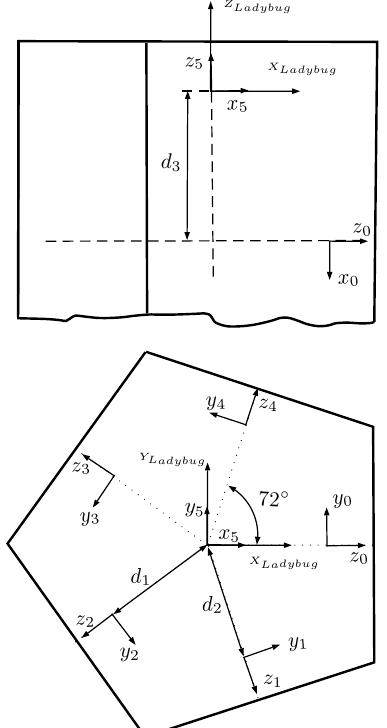
Figure 12. The geometrical unknowns during the first estimation of the extrinsic parameters of the cameras are: d (for Cameras 0, 2 and 3), d (for Cameras 1 and 4), d (for Camera 5) 1 2 3 and the exact orientation of each camera. Side view (top) and top view